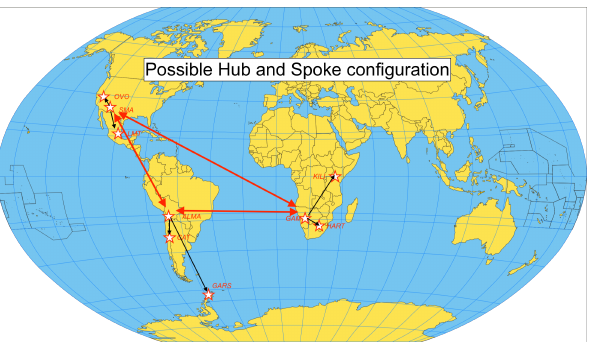
Figure 6. An example of sites that could form a hub-and-spoke configuration suitable for observing SgrA*, as used in our simulations. The black lines connect smaller antennas to a hub that provides the calibration reference site. These highly sensitive hub-based facets can then be connected together on their edges, or self-calibrated separately. Edited world map taken from Wikipedia.